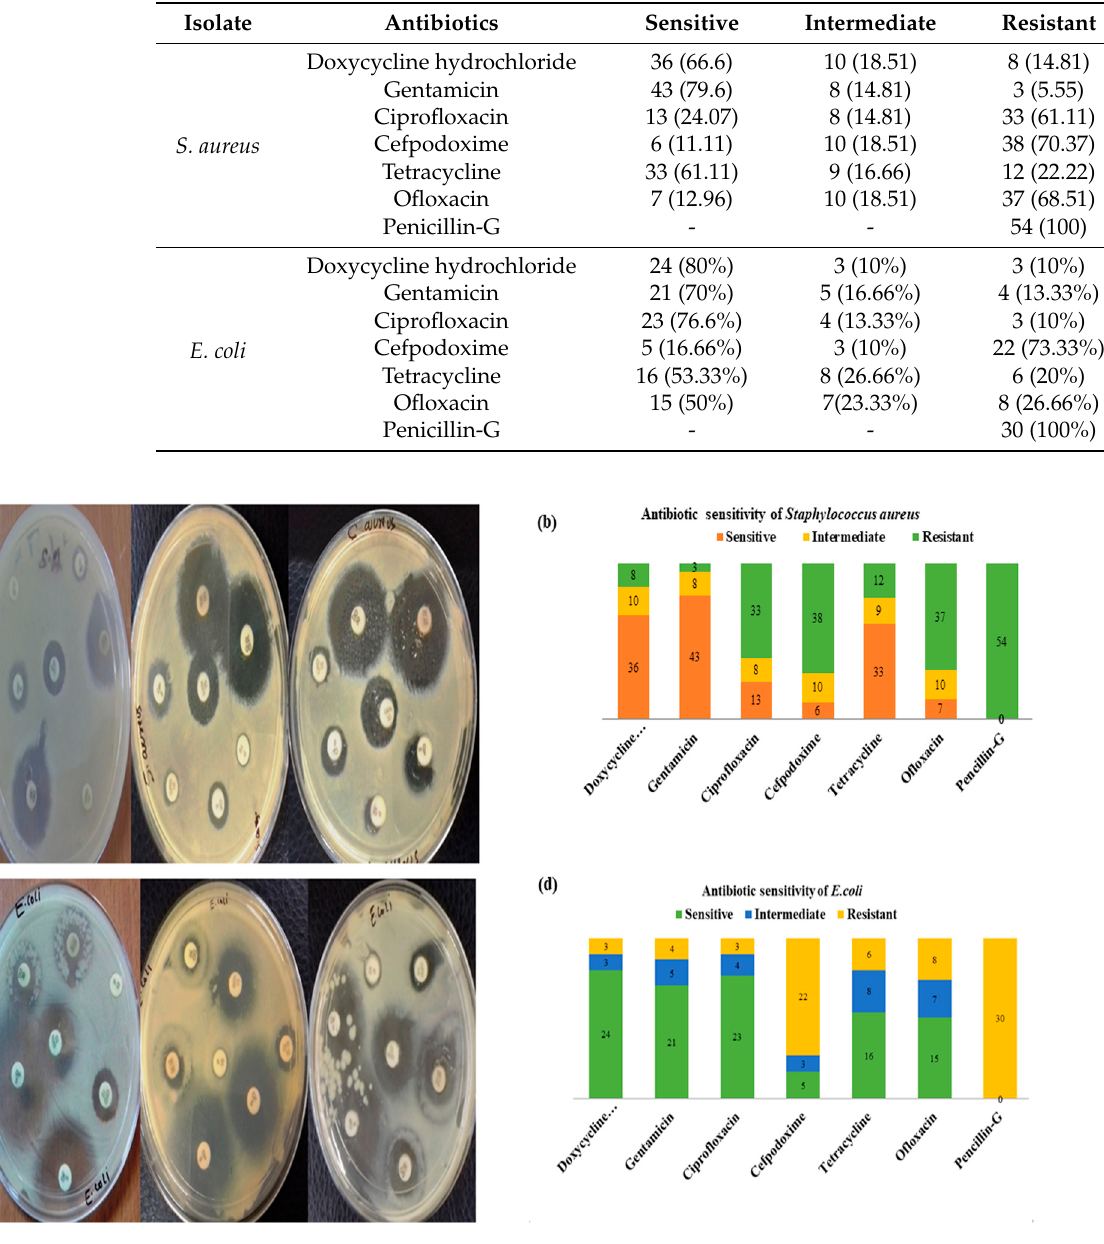
Figure 6. ( a ) Antibiotic sensitivity test of isolated S. aureus (Kirby–Bauer method); ( b ) percent- age of antibiotic activity for S. aureus (DO—Doxycycline hydrochloride, GEN—Gentamycin, CIP— Ciprofloxacin, CPD—Cefpodoxime, TE—Tetracycline, OF—Ofloxacin, PEN—Penicillin; ( c ) antibi- otic sensitivity test of the isolated E. coli (Kirby–Bauer method); ( d ) percentage of antibiotic activ- ity for E. coli . (DO—Doxycycline hydrochloride, GEN—Gentamycin, CIP—Ciprofloxacin, CPD— Cefpodoxime, TE—Tetracycline, OF—Ofloxacin,